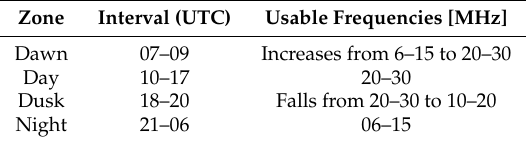
Table 5. Summary of the results for the narrowband analysis in terms of availability by time